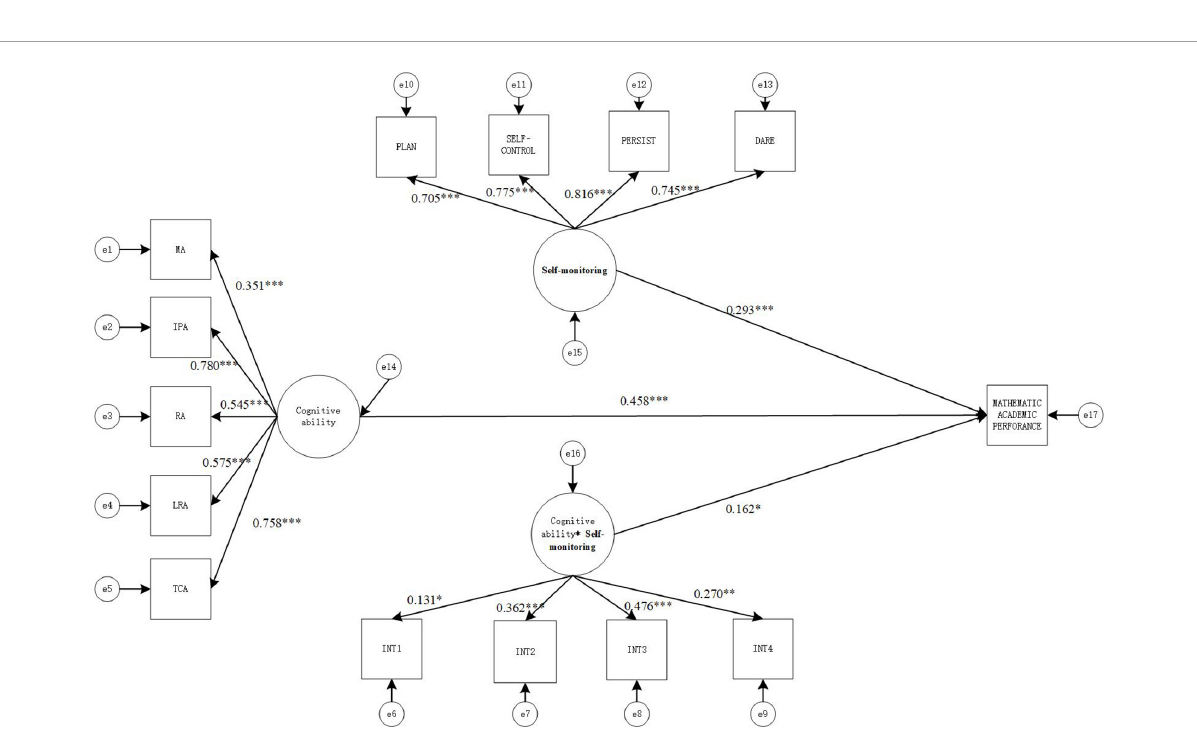
FIGURE4 Structural equation moderating effect relationship model diagram (model 3). MA, memory ability; IPA, information processing ability; RA, representation ability; LRA, logical reasoning ability; TCA, thinking conversion ability.* p < 0.05, ** p < 0.01, and *** p <